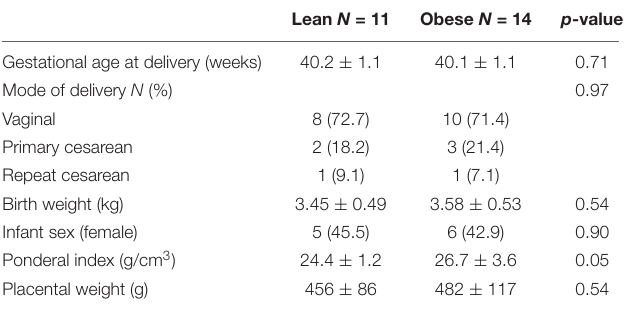
TABLE 1 | Pregnancy and neonatal